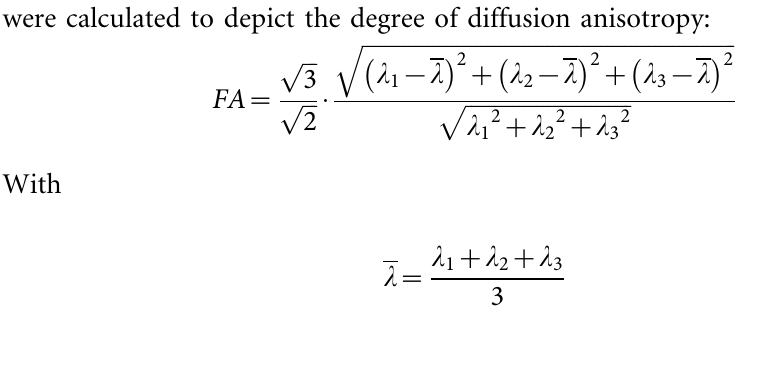
ffiffiffiffiffiffiffiffiffiffiffiffiffiffiffiffiffiffiffiffiffiffiffiffiffiffiffiffi l 12 z l 22 z l 32